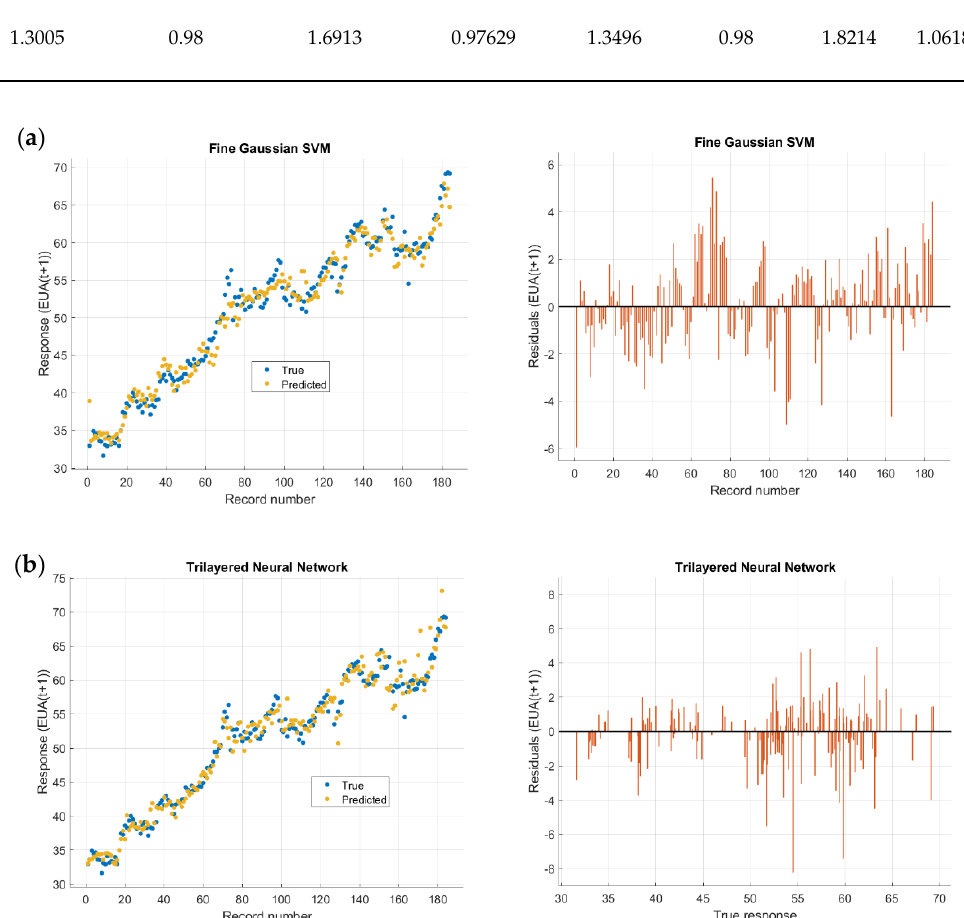
Figure 10. Comparison of the results of day-ahead carbon price forecasts by useof: ( a ) SVM model (for train data), ( b ) NNR model (for train data).